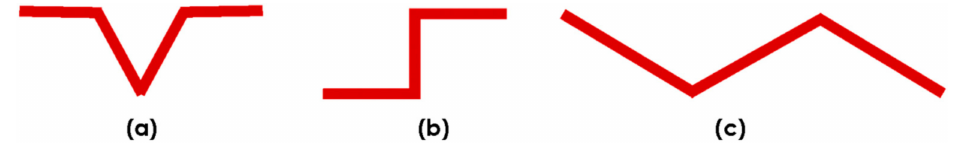
Figure 10. Simplified representation of carapace surface-grooves: ( a ) V-groove; ( b ) step; ( c ) zigzag.